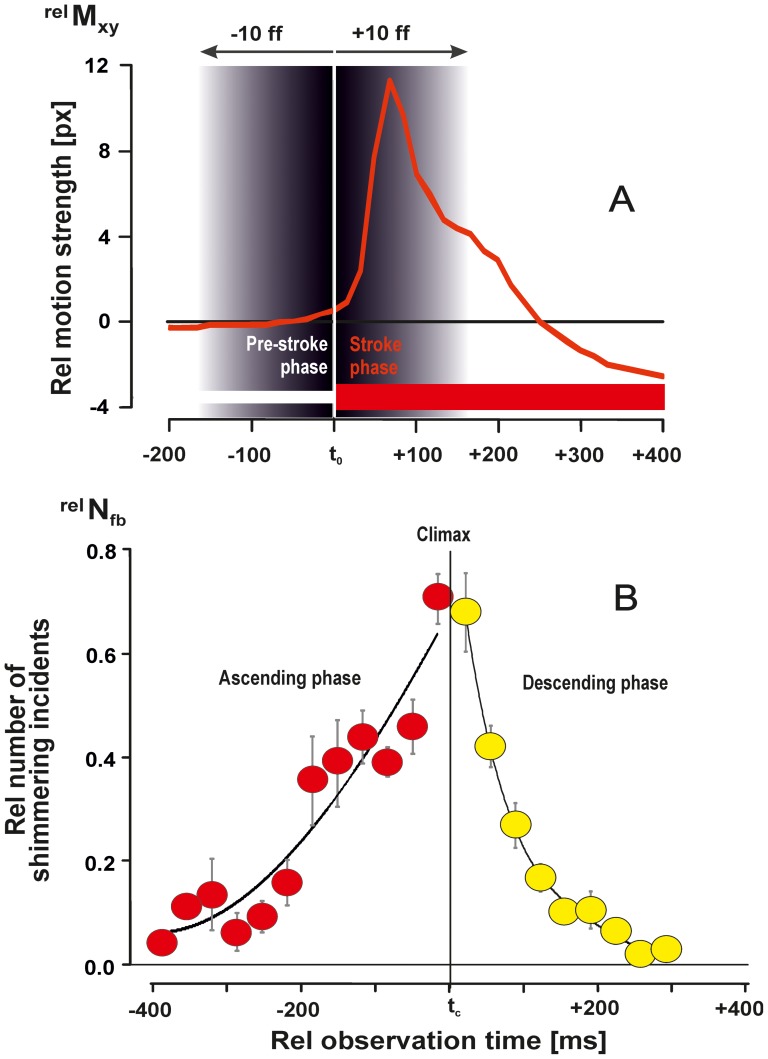
Definition of a shimmering incident and of the three phases of a shimmering wave.(A) Typical time course of the motion of an individual focus bee during abdominal flipping (termed shimmering incident): ordinate: relative motion strength assessed by  (for definitions, see Methods). Abscissa, observation time in ms; , start time of the shimmering incident of the agent, and start time of the stroke phase, synonymous to the post-[

]-stroke phase; Grey shaded zone, the time window of ±167 ms (≡±10 ff) for categorizing the communication status of agents (see text). (B) The three phases (ascending, climax, descending) of a shimmering wave can be categorized by the course of recruitment of agents participating in a wave, quantified by the relative number of shimmering incidents which were traced per image at the relative observation time  with  [per wave] and  = 10,894 (see Methods; n = 25 episodes of 2 min duration). Full circles, arithmetical, vertical bars, SEMs; n = 40 waves. The time  gives the time point of the climax when the maximum number of shimmering incidents () occurred simultaneously. Red colour marks the ascending phase (<) of the shimmering waves, yellow colour marks the descending phase (>).